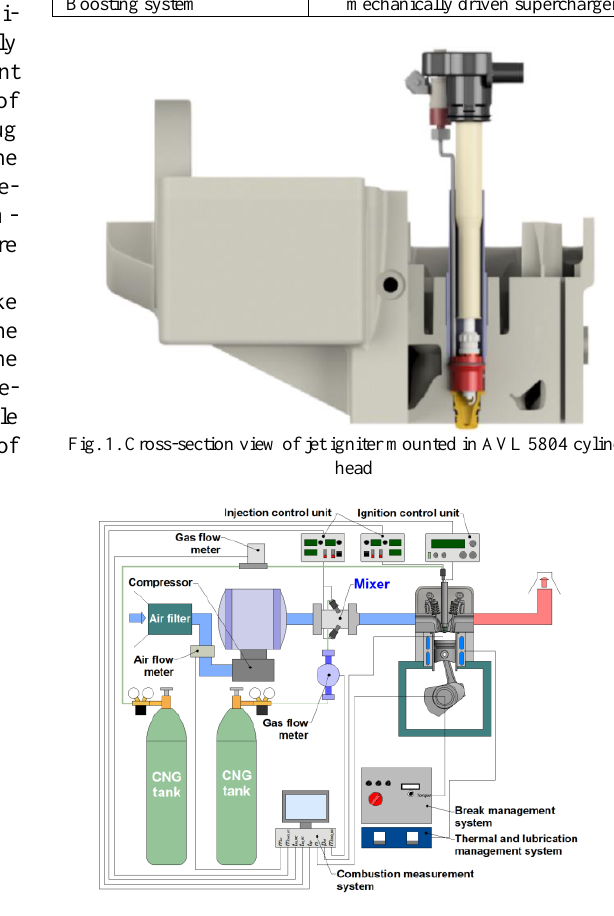
Fig. 3. Schematic of single cylinder engine test stand with mixer (M) injection